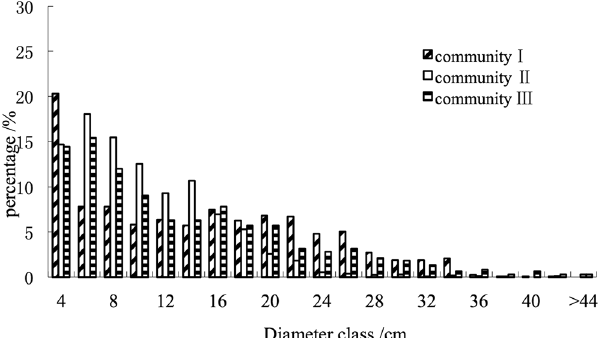
Figure 2. Dbh distributions of all species in the three 1-ha plots. X-axes display size classes in 4 cm intervals, y-axes display number percentage of individual trees.